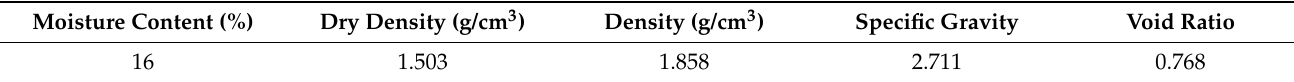
Table 1. The physical index properties of loess.